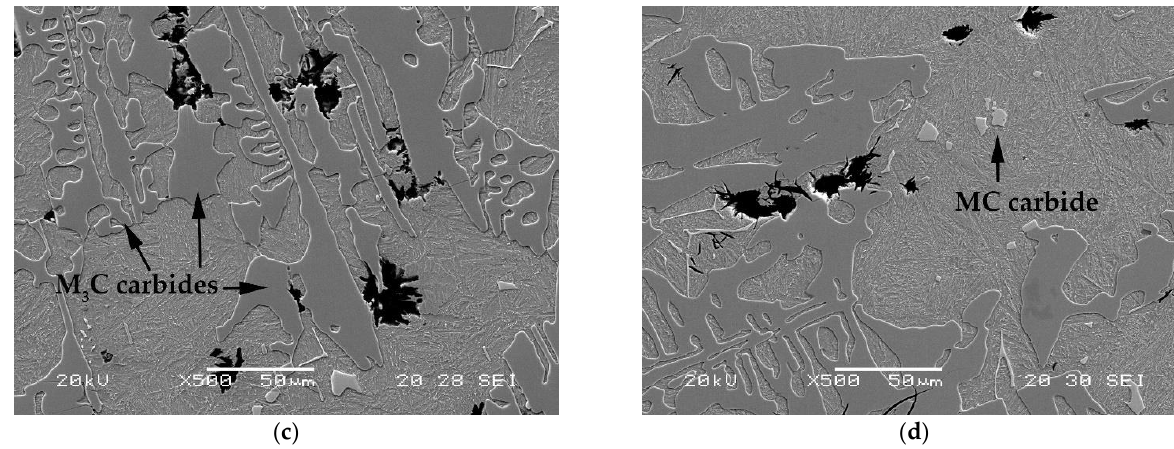
Figure 3. General microstructure of the work layer. ( a ) Experiment 1 in zone III; ( b ) experiment 3 in zone I; ( c ) experiment 4 in zone III; ( d ) experiment 7 in zone I.